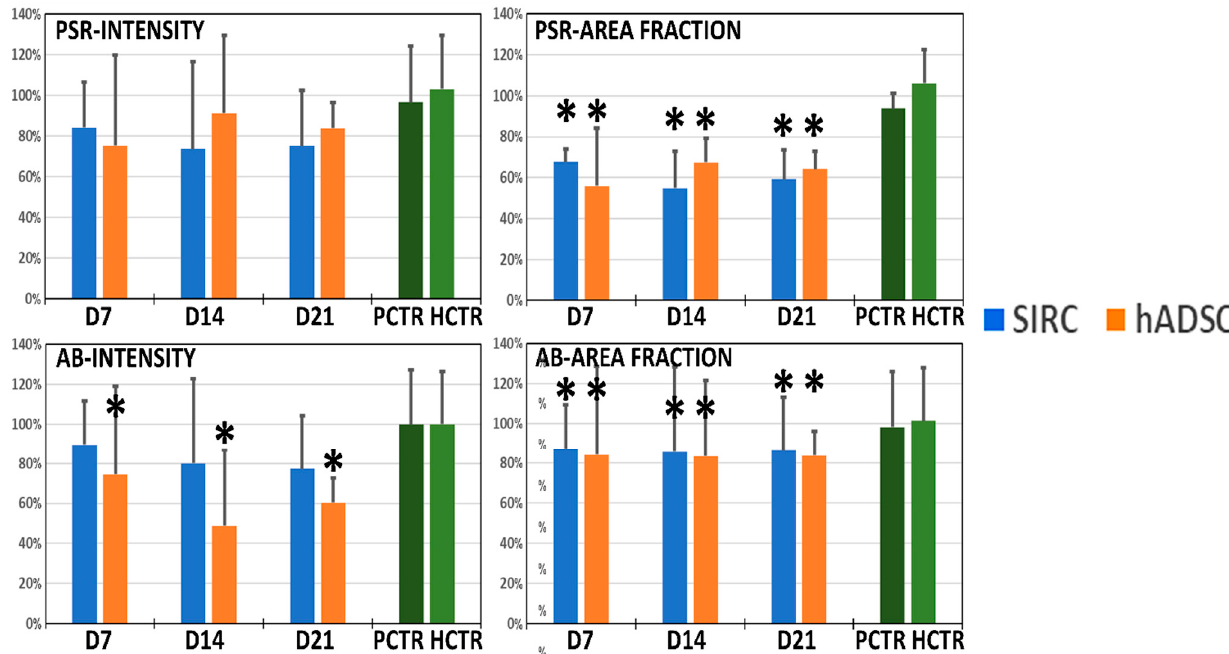
Figure 8. Histochemical analysis of native porcine limbus (PCTR), native human limbus (HCTR), and limbi recellularized with SIRC cells and hADSCs evaluated at days 7 (D7), 14 (D14), and 21 (D21) of follow ‐ up. PSR: picrosirius red, AB: alcian blue. Scale bars: 50 μ m.